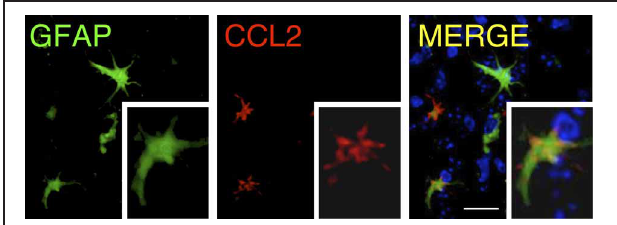
FIGURE 2 | Distribution of CCL2 in GFAP + astrocytes. Confocal rendering of an area of LPS-induced inflammation in the mouse brain. Astrocytes are labeled using immunohistochemistry with antibodies against GFAP (green), and the chemokine CCL2 is stained with anti-CCL2 antibodies (red). Nuclei are counterstained with DAPI (blue). CCL2 is expressed in astrocytes, and its intracellular distribution is higher in the terminal GFAP filaments [modified from Carrillo-de Sauvage et al. (2012)]. Scale bar: 30 μ